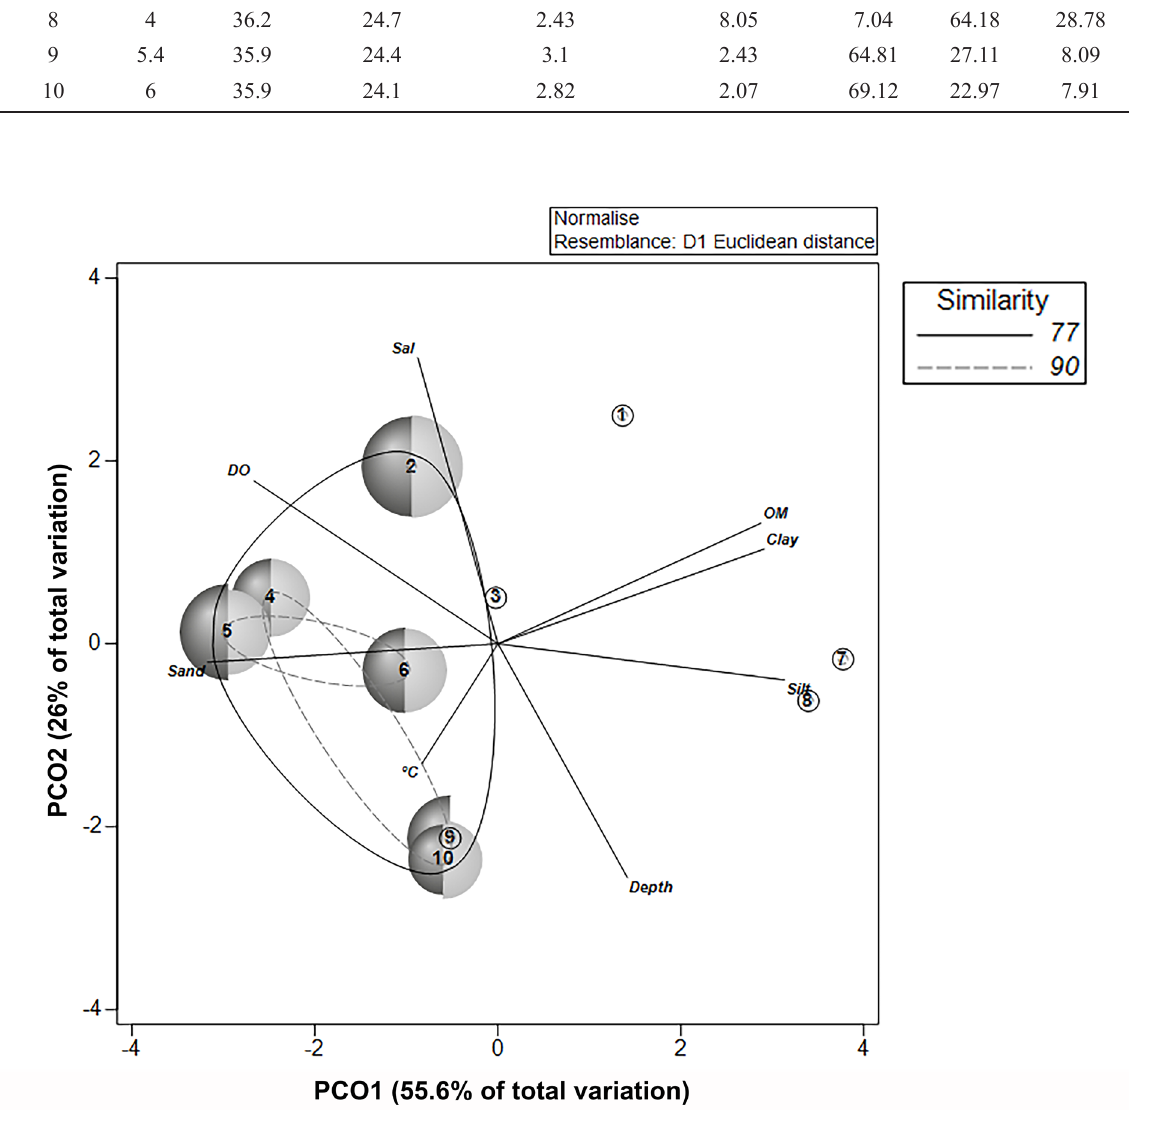
Fig. 21. Principal coordinates analysis between environmental variables (DO = dissolved oxygen; Sal = salinity; OM = organic matter content; temperature in °C; depth in m; grain size: sand, silt, clay), and mean density of T. medici sp. nov. (light grey semicircles) and S. primus gen. et sp. nov. (dark grey semicircles) at the sampling stations (Arabic numerals) along the Urías